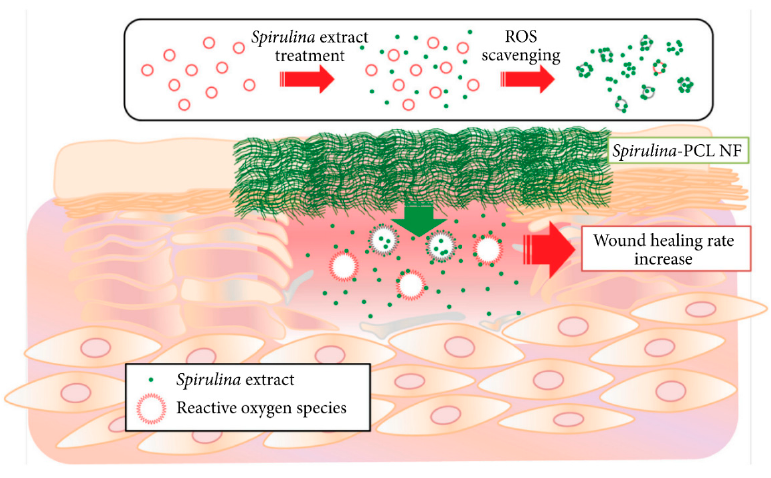
Figure 7. Schematic design of the Spirulina -PCL nanofibers application to cutaneous wound. Pub- lished by Ref. [40].